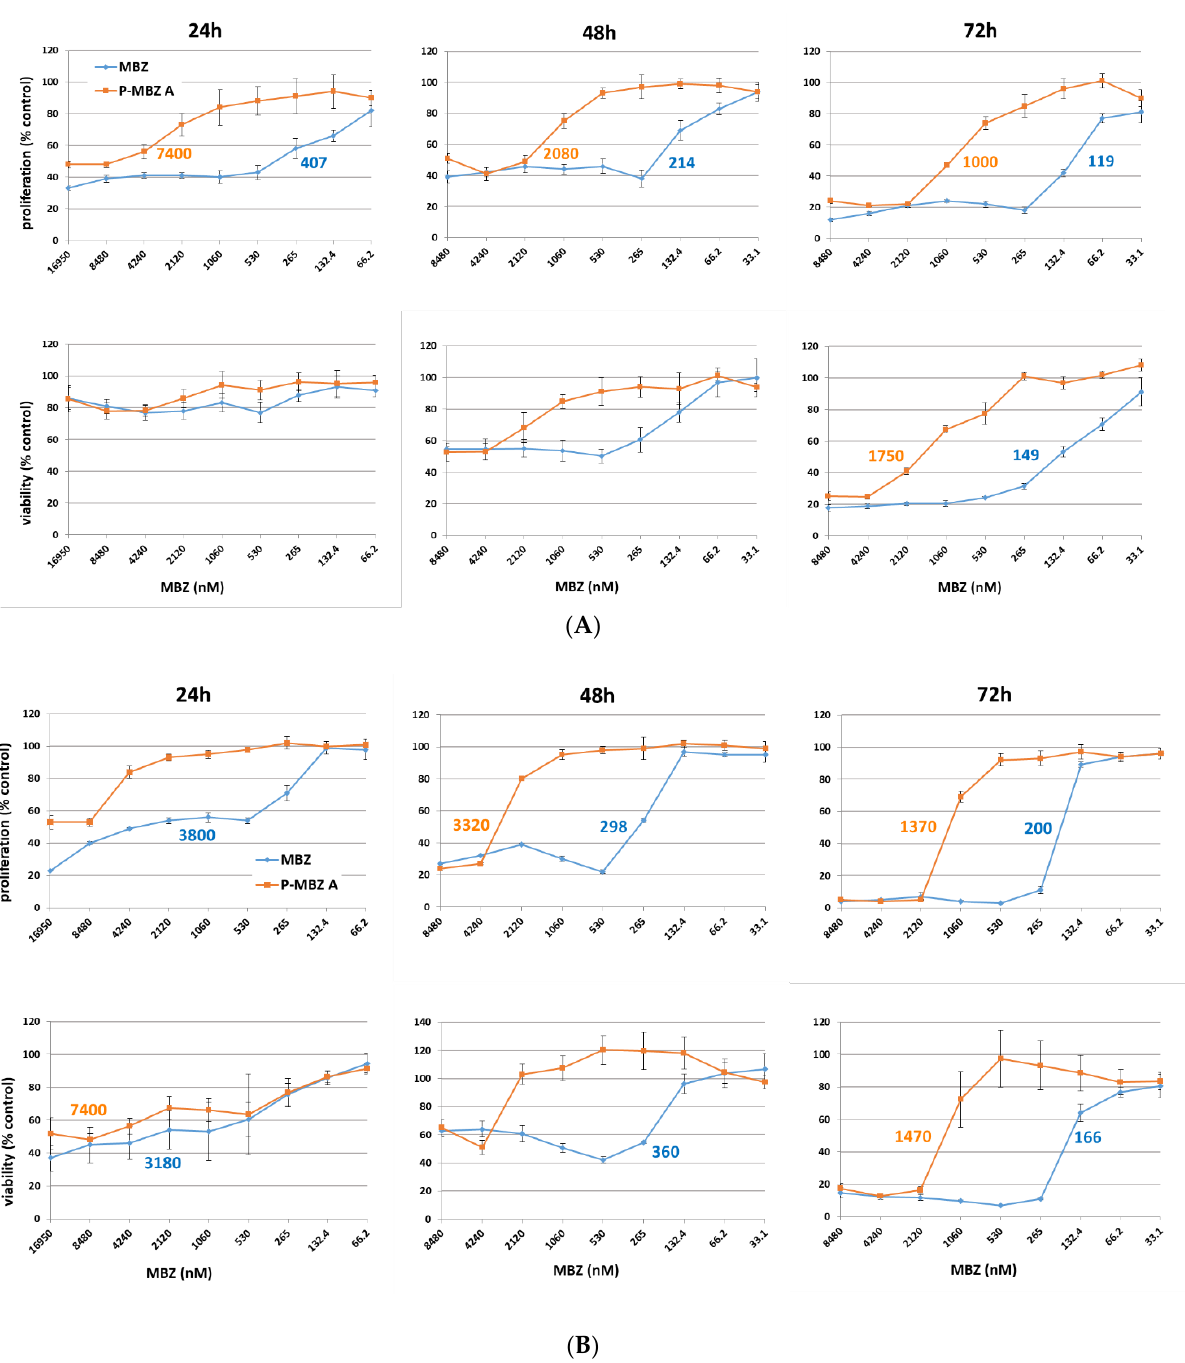
Figure 5. Kinetics of the cytostatic and cytotoxic activities of polymer-bound mebendazole conju- gate. Cytostatic activity of HPMA copolymer-bound mebendazole conjugate ( P-MBZ-A ) and free mebendazole (MBZ) in LL2 ( A ) and EL-4 ( B ) murine cancer cell lines in vitro, as determined by [ 3 H]- thymidine incorporation and MTT assays, respectively, after 24, 48, and 72 h of incubation. The calculated IC 50 values (nM) are shown inside the graphs for those samples where these values were reached. Each experiment was performed in quadruplicate, and the results are shown as the prolif- eration or viability of exposed cells relative to the controls (untreated cells) ± SD. The experiment was repeated with similar results. repeated with similar